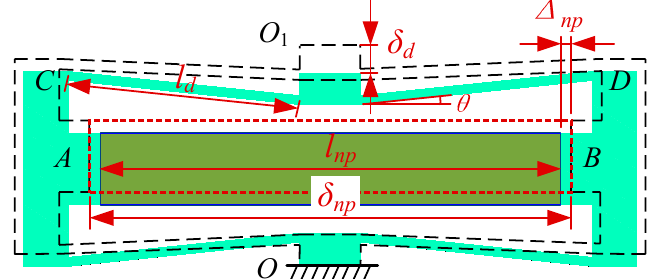
Figure 2. Deformation of displacement amplification mechanism.